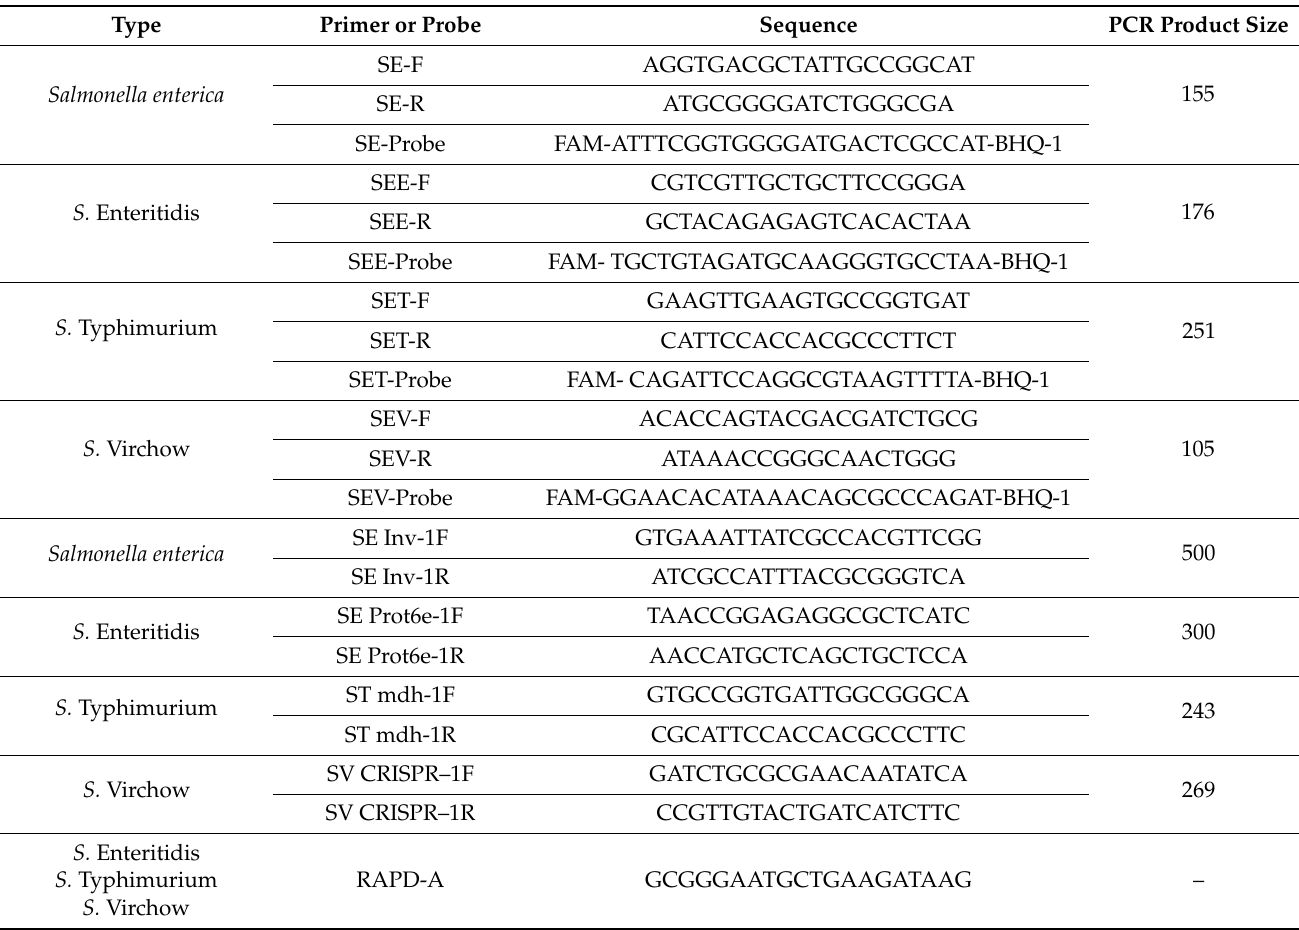
Table 2. Oligonucleotide primers and probes for identification of Salmonella enterica species and their types in real-time PCR and